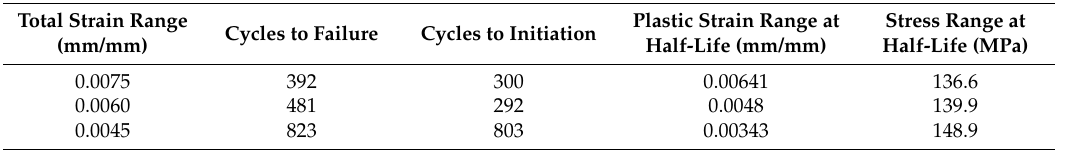
Table 2. LCF test reports of Alloy 617 completed at 950 °C and at a strain rate of 10 − 3 /s. Total Strain Range Cycles to Failure (mm/mm)